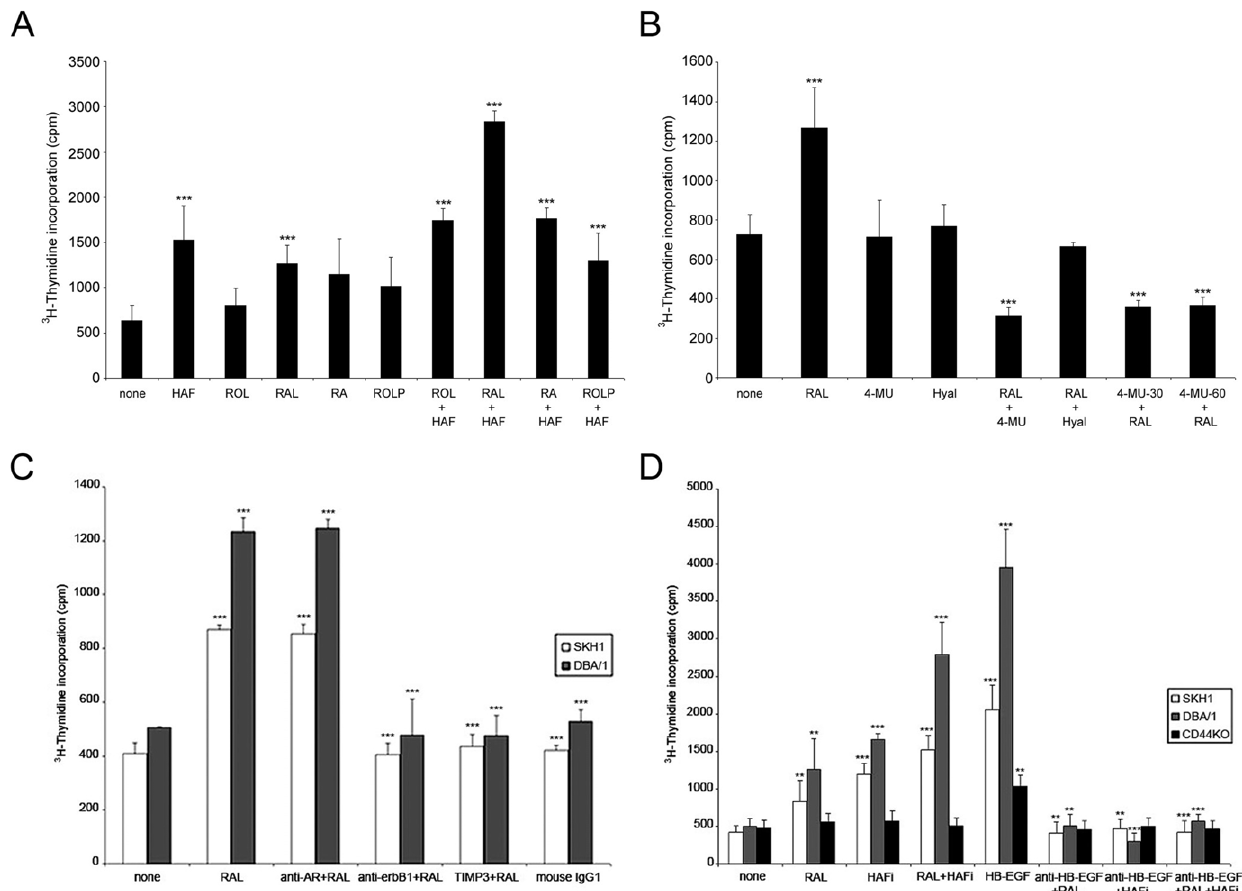
Figure 1. The effect of retinoids and HAFi invitro . A. RAL is the most potent retinoid to induce keratinocyte proliferation. Keratinocytes from DBA/1 mice were cultured in 96-well plates. On day 2 of culture, HAFi (100 m g/ml), RAL (2 m M), RA (2 m M), ROL (2 m M), ROLP (2 m M), RAL + HAFi, RA + HAFi, ROL + HAFi or ROLP + HAFi was added to the cultures. 48 hrs later 1 m Ci of [ 3 H]thymidine was added to each well. All experiments were done in triplicate and repeated 5 times. The results are presented as the mean incorporated counts per minute 6 SEM of three wells per group. ***p , 0.001(HAFi versus none; RAL versus none, RA, ROL and ROLP; RAL + HAFi versus all; ROL + HAFi versus none; RA + HAFi versus none; ROLP + HAFi versus none) (student’s t test). B. RAL-induced HA synthesis is required for keratinocyte proliferation. Keratinocytes from DBA/1 mice were cultured in 96-well plates. On day 2 of culture, RAL (2 m M), 4-MU (0.6 mM) [alone or together with RAL (RAL + 4-MU) or 30 (4-MU-30 + RAL) or 60 (4-MU-60 + RAL) minutes before RAL] or hyaluronidase (1 U/ml) [alone or together with RAL (RAL + Hyal)] was added to the cultures. 48 hrs later 1 m Ci of [ 3 H]thymidine was added to each well. All experiments were done in triplicate and repeated 5 times. The results are presented as the mean incorporated counts per minute 6 SEM of three wells per group. ***p , 0.001(RAL versus none, RAL + 4-MU, 4-MU-30 + RAL and 4-MU-60 + RAL; RAL + 4-MU, 4-MU-30 + RAL and 4- MU-60 + RAL versus none) (student’s t test). C. RAL induces in vitro mouse keratinocyte proliferation which is inhibited by anti-erbB1 and TIMP-3. Keratinocytes from SKH1 and DBA/1 mice were cultured in 96-well plates. On day 2 of culture, RAL (2 m M), monoclonal anti-human